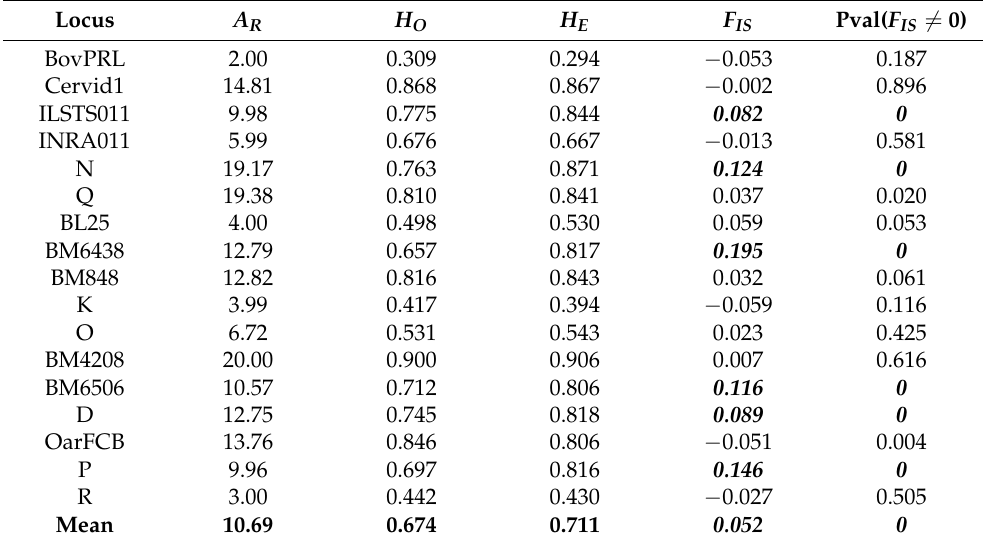
Table 1. Locus-specific genetic diversity estimates for n = 640 deer in the total population. Allelic richness ( A R ), observed heterozygosity ( H O ), unbiased expected heterozygosity ( H E ), and Wright’s inbreeding coefficient ( F IS ) are provided. Significance of F IS is given using permutation tests with 10,000 randomizations of gene copies among individuals; significant values in bold. Locus A R H O H E F IS Pval( F IS (cid:54) = 0) BovPRL